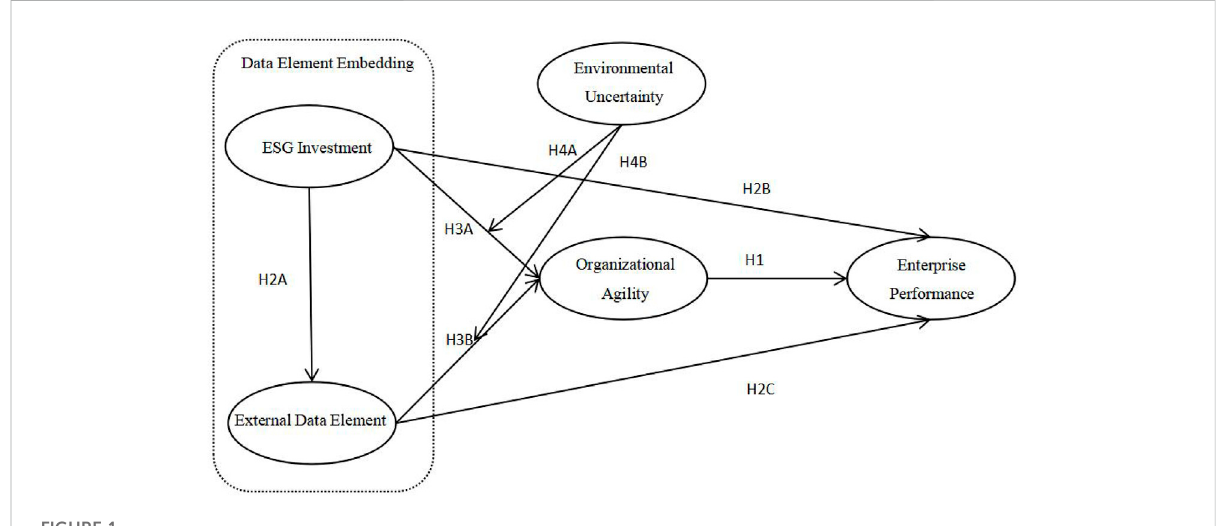
FIGURE 1 Theoretical model.